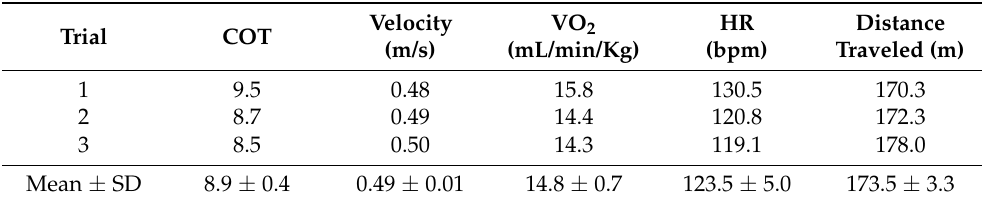
Table 6. Metabolic cost estimation following the 6 min walking test wearing KAEGO with 25% rated power.